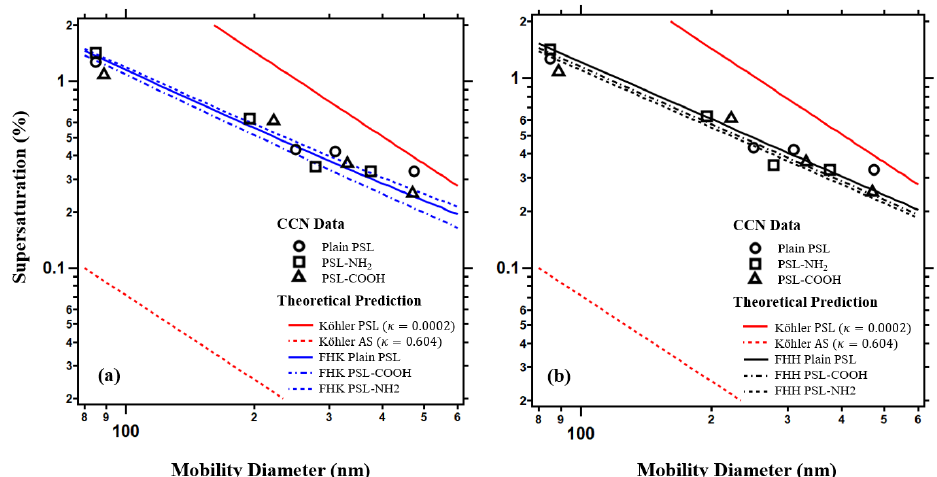
Figure 1. The s c – D d data for different types of PSL. The dashed red line is the tradition Köhler prediction for ammonium sulfate ( κ = 0 . 604). All types of PSL particles are more hygroscopic than the intrinsic hygroscopicity ( κ int = 0 . 0002, solid red line). (a) Blue lines show the prediction from FHK. (b) Black lines show the prediction from FHH-AT model, with B FHH = 1.